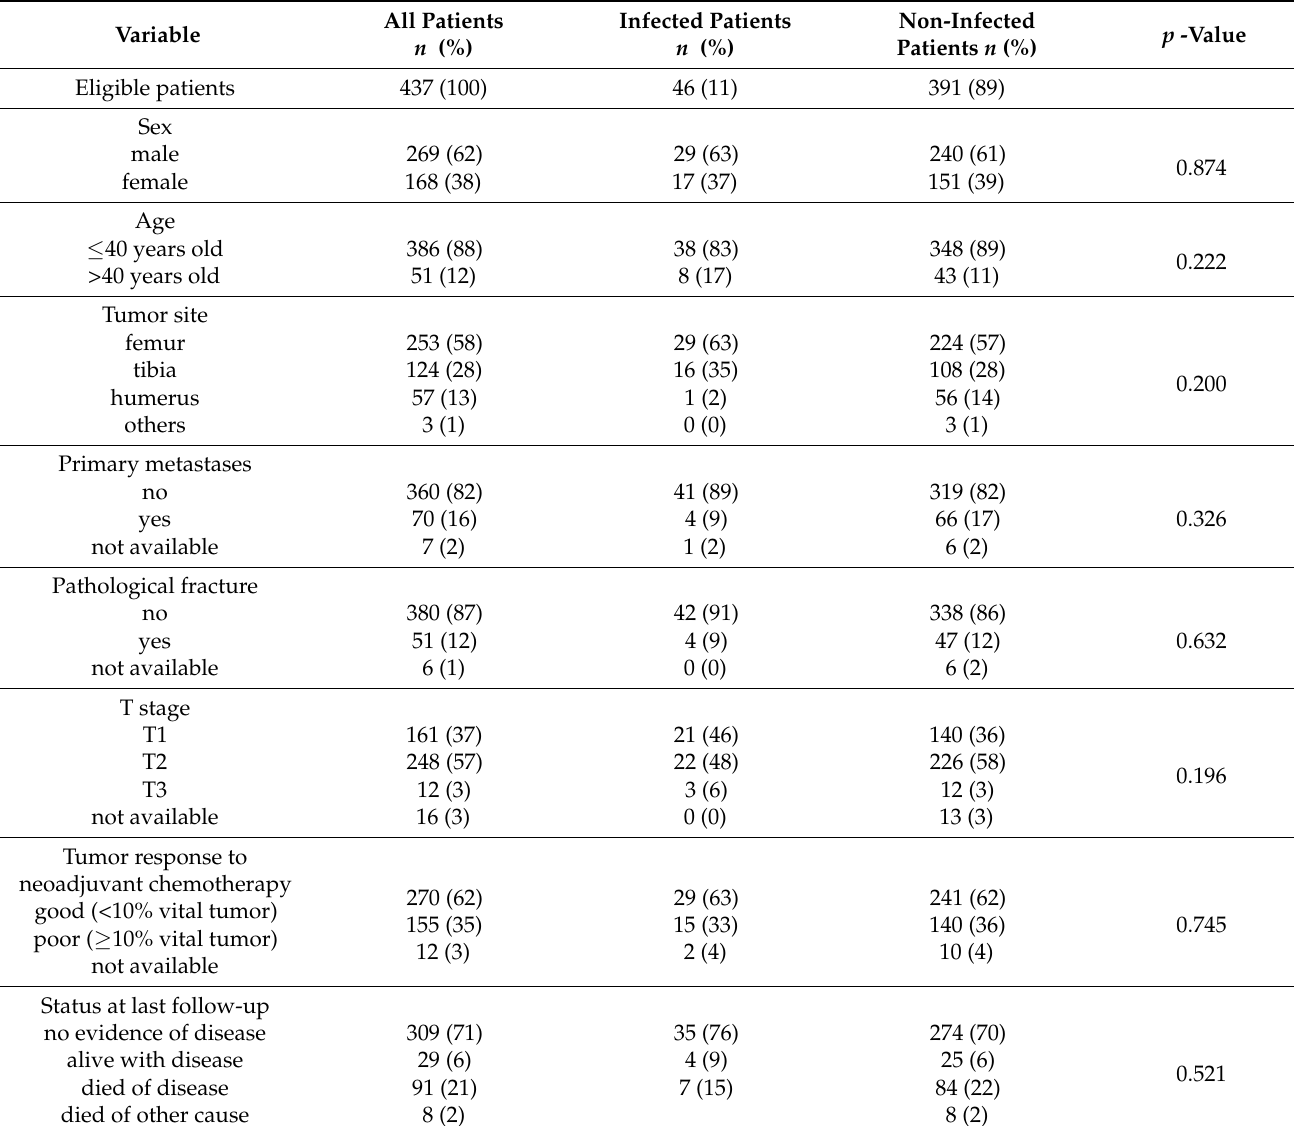
Table 1. Patient demographics, tumor characteristics, primary treatment, and status at last follow-up for all patients, patients with, and patients without an early